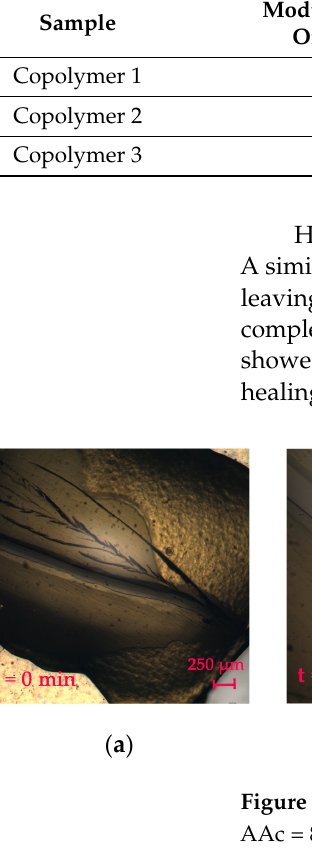
( d ) Figure 9. Optical microscopic images of healing accelerated by HCl of copolymer 2 (AAm/AAc = 49.5/49.5): ( a ) t = 0 min; ( b ) t = 1 min; ( c ) t = 5 min; ( d ) t = 10 min.